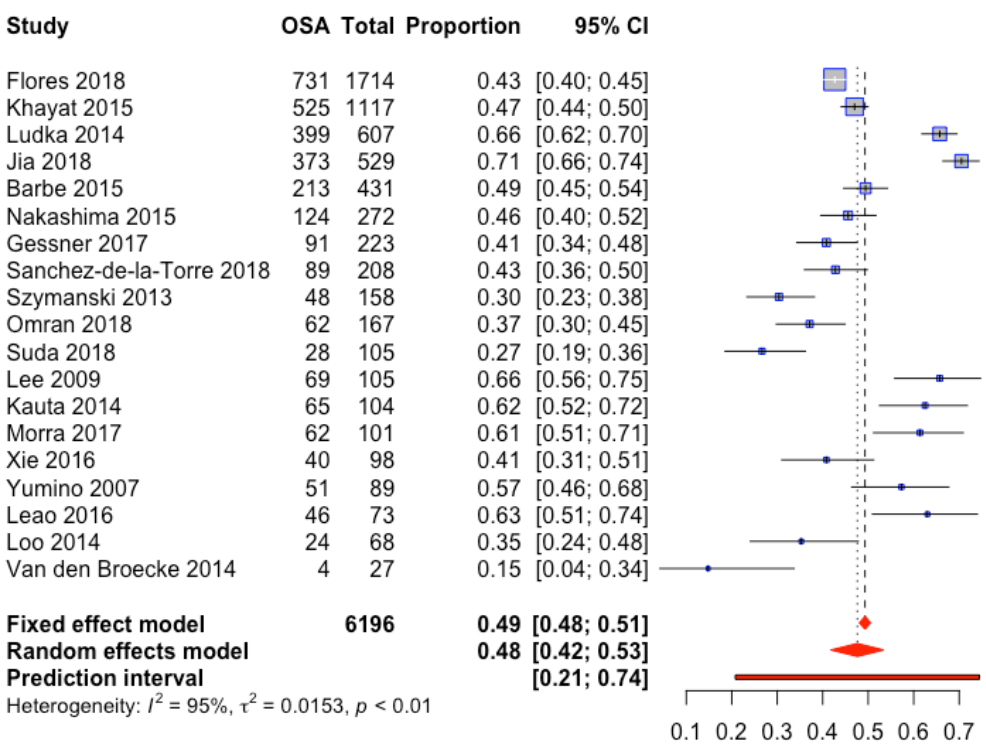
Figure 2. Forrest plot of OSA prevalence among hospitalized cardiac inpatients.